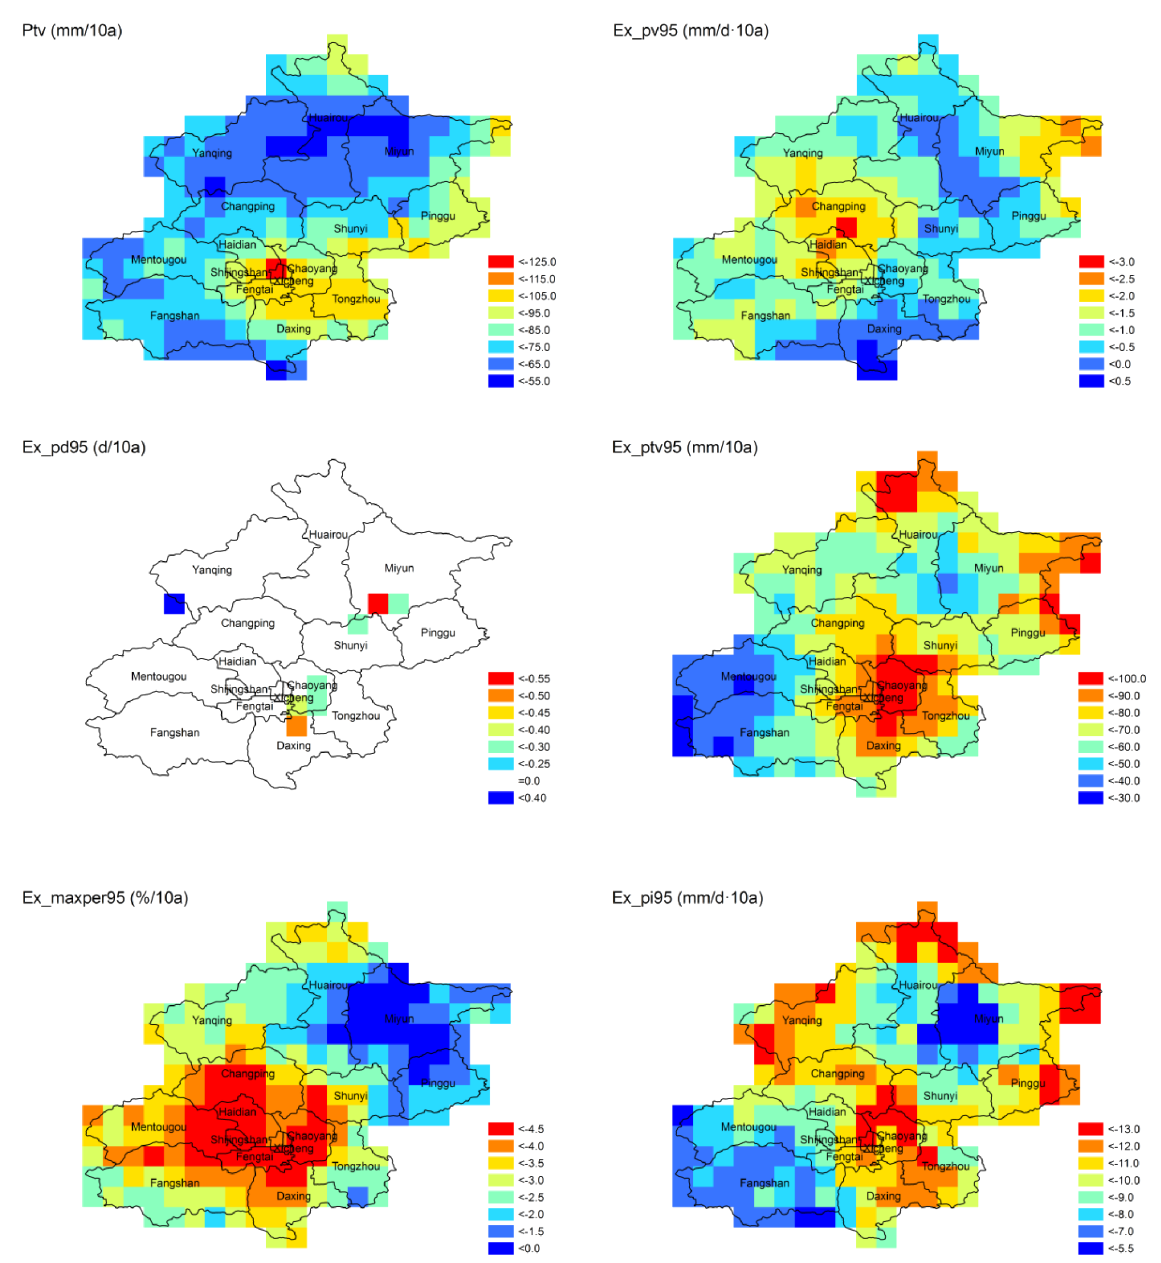
Figure 3. Trends of extreme precipitation based on 3h gridded data during 1979–2012. (The variables are same as Fig.